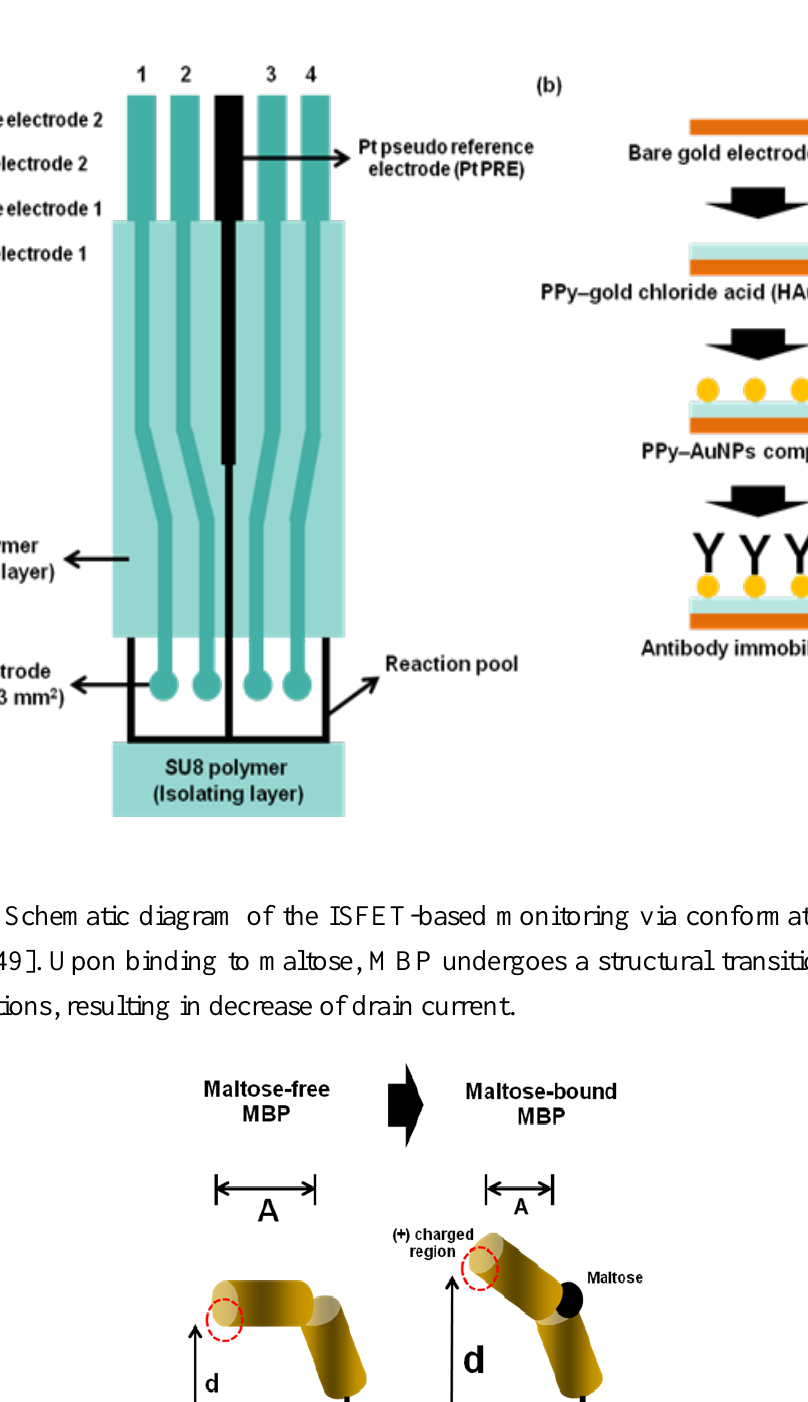
Figure 3. Schematic diagrams of the micro-potentiometric immunosensore (a), and antibody immobilization strategy (b) [48].